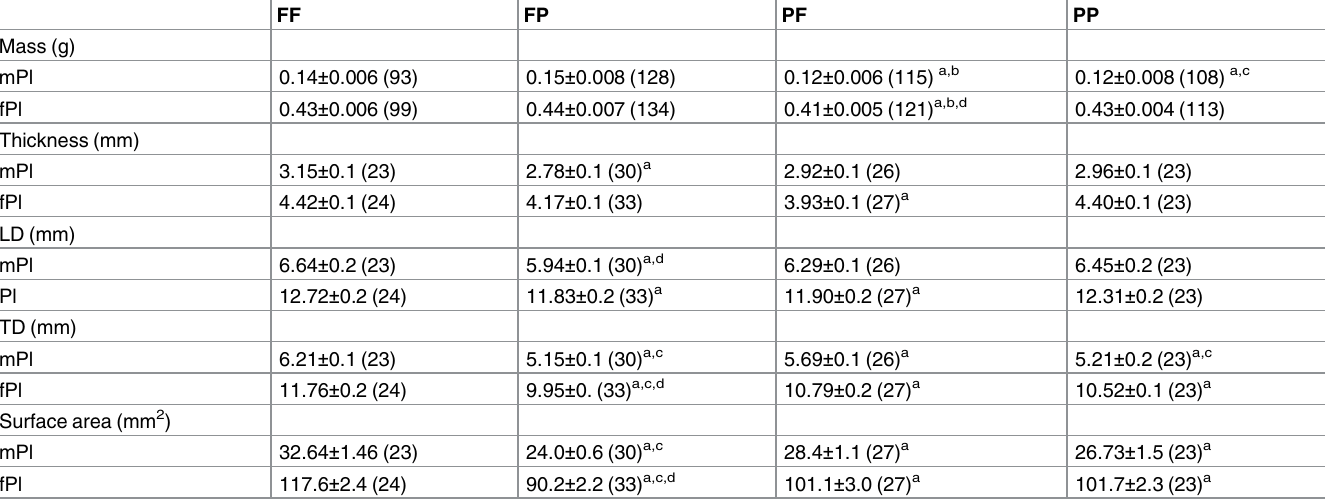
Table 4. Mass, thickness, longitudinal and transversaldiameters and surface area of the